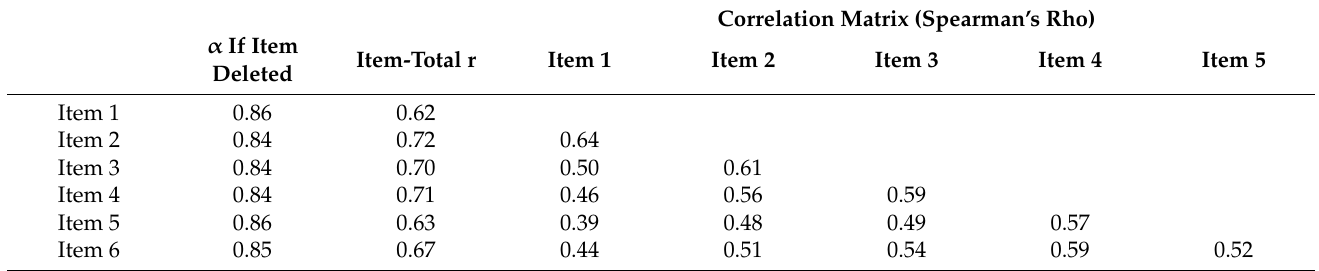
Table 3. Alpha if item deleted and correlations with other items for each BSMAS item.